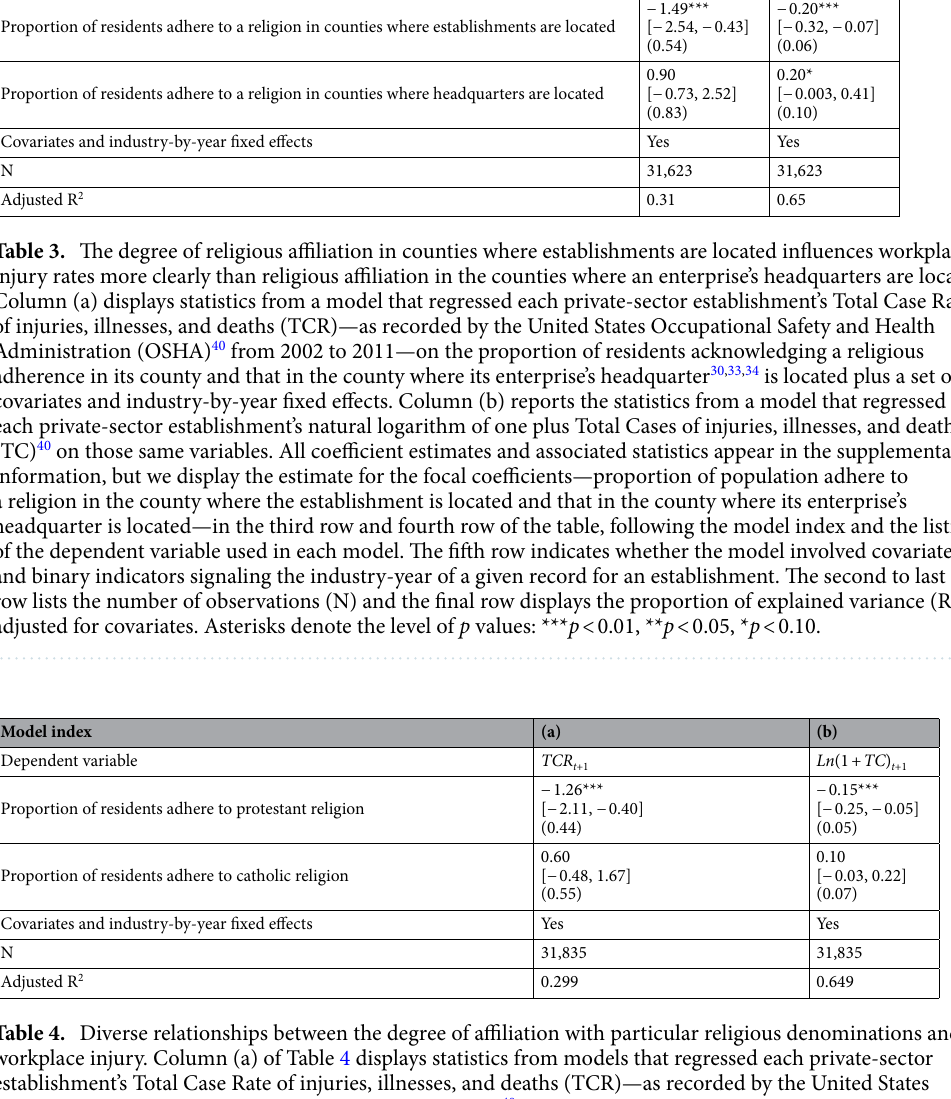
hand, the coefficient estimate for the Catholic adherence variable nearly equals its associated standard error, thus resulting in a 95%-confidence interval that spans zero. Religion’s effect on injuries in the presence of strong labor unions. Our findings suggest that the rate of religious adherence influences worker safety, just as past research indicates that religious adherence increases prosocial behaviors. However, the latter line of inquiry also reports that the effects of religious adher- ence become muted in the presence of “earthly” authorities that can sanction misbehavior 41 . In the context of our study, labor unions perform this “earthly” role by monitoring working conditions and threatening sanctions— such as work stoppages or lawsuits—if workplace conditions are unsafe. Accordingly, we divided our full sample into two groups, one with strong union power and the other with weak union power, then regressed in each